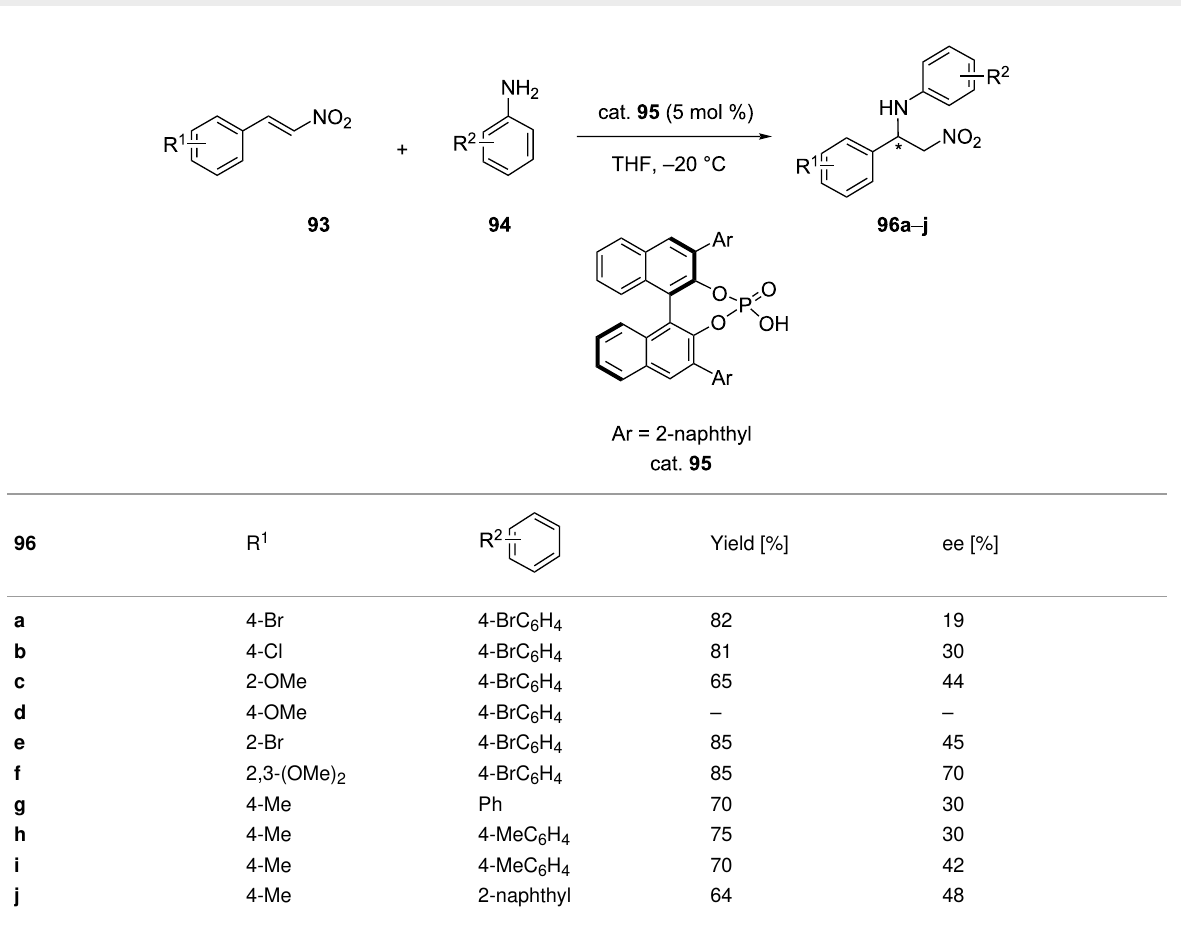
Table 21: Asymmetric aza-Michael addition of aniline to β